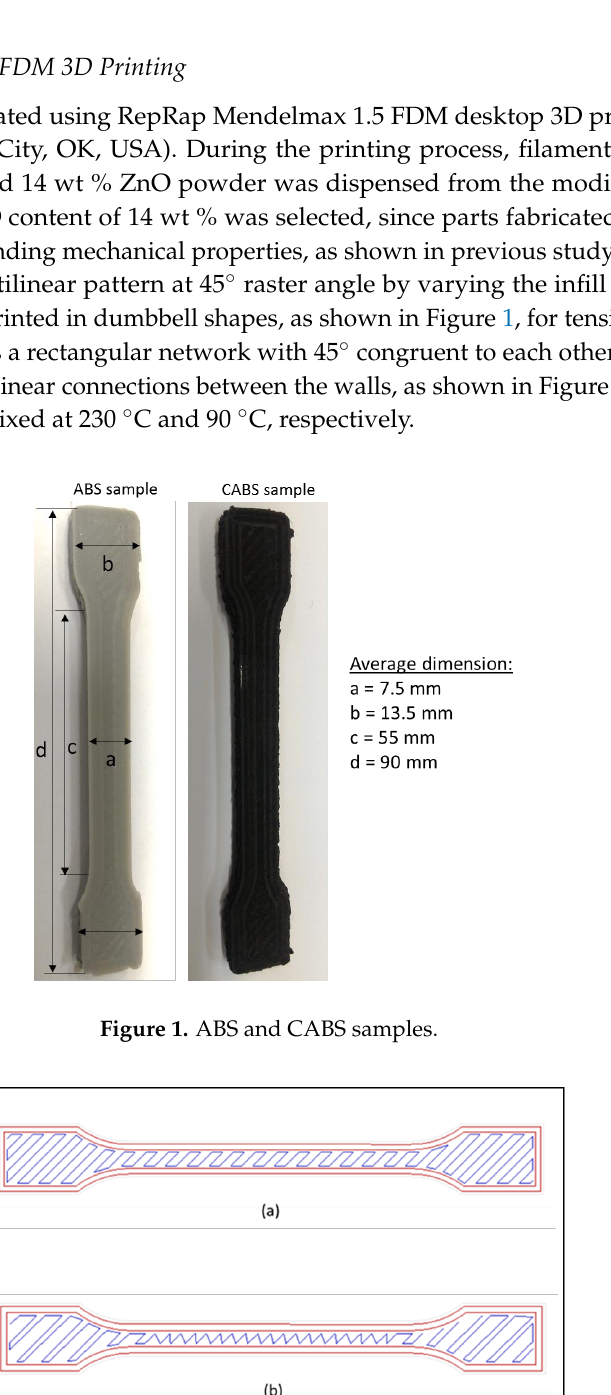
Figure 2. Different printing patterns (Image from Slicer software, [19]). ( a ) Rectilinear and ( b ) line.